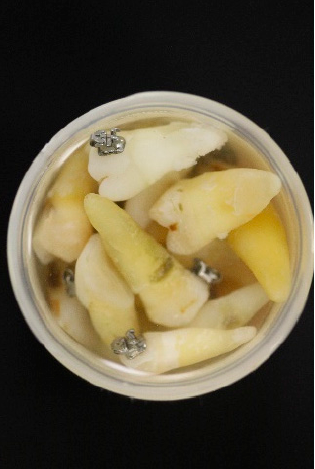
Figure 4. Teeth with bonded brackets in artificial saliva.